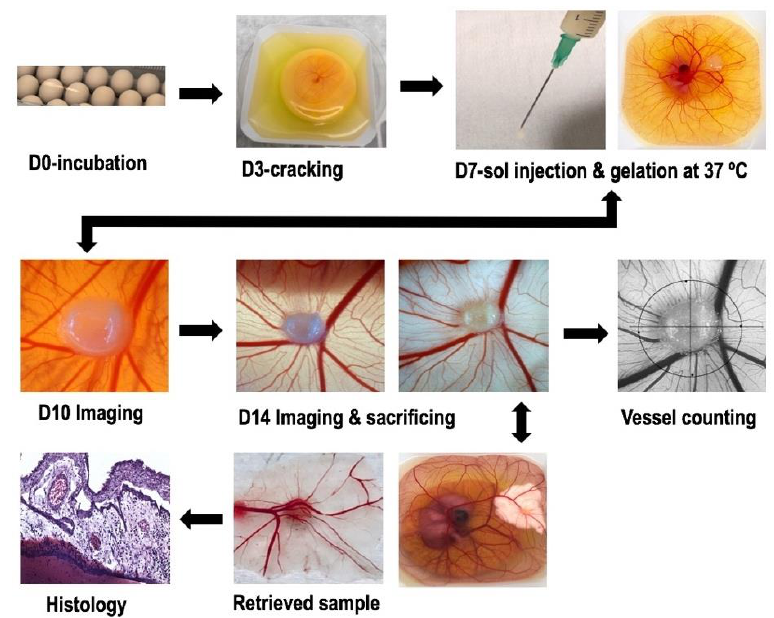
Figure 15. The process diagram for ex-ovo CAM assay technique to investigate pro-angiogenic potential of pH and thermosensitive injectable CS / HA / Hep hydrogels, vascular index counting in Image-J ® (Version 1.52 k, National Institutes of Health, Bethesda, MD, USA) Software, and example histology sectioned sample.